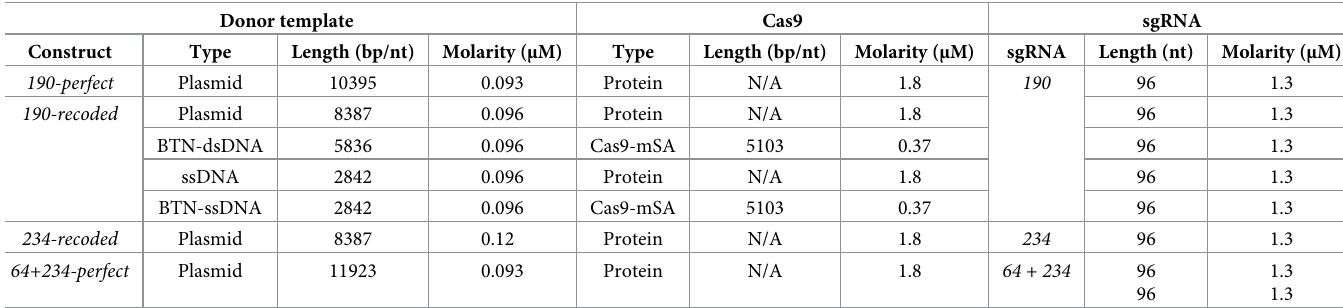
Table 2. Concentration of each component in injection